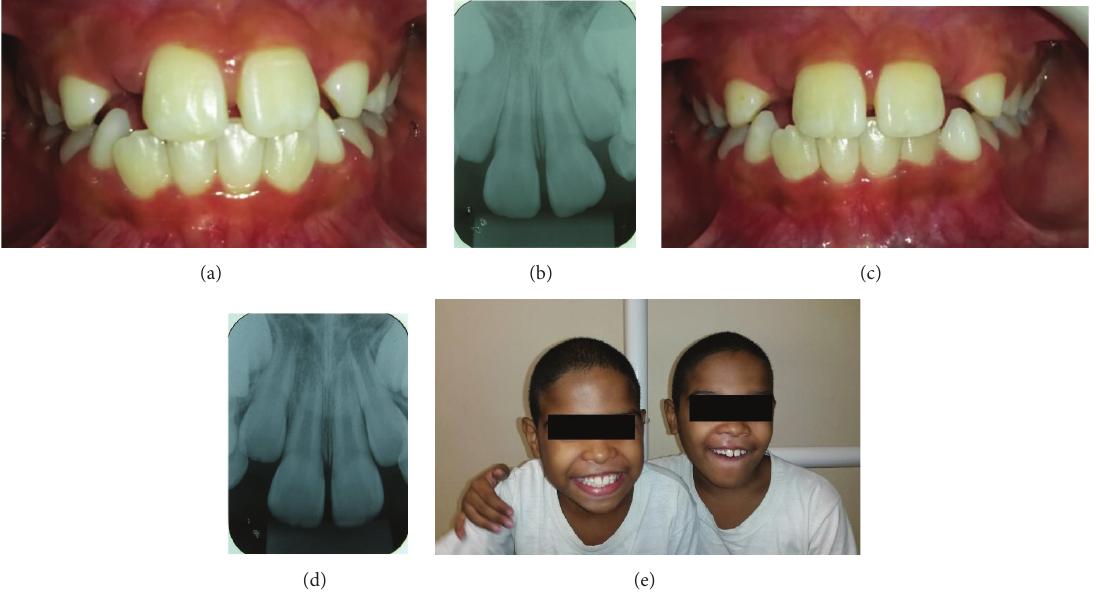
Figure 3: Six months later, after treatment. (Case 1: (a), (b); Case 2: (c), (d)) Central incisors were in normal position and there was no relapse. Periapical radiographs of upper central incisor teeth. There was no pathological condition ((e): twin boys